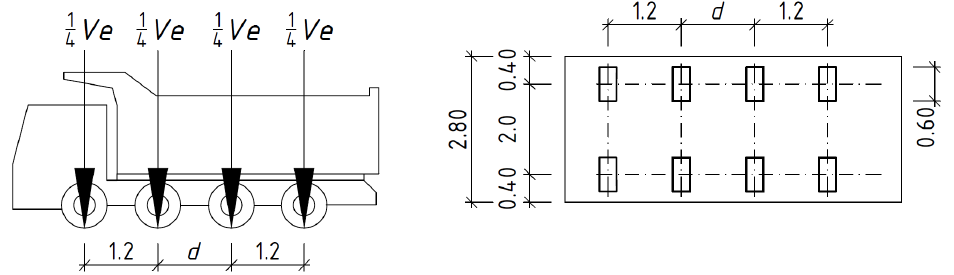
Figure 12. Scheme of vehicle used for exclusive load ‐ carrying capacity.